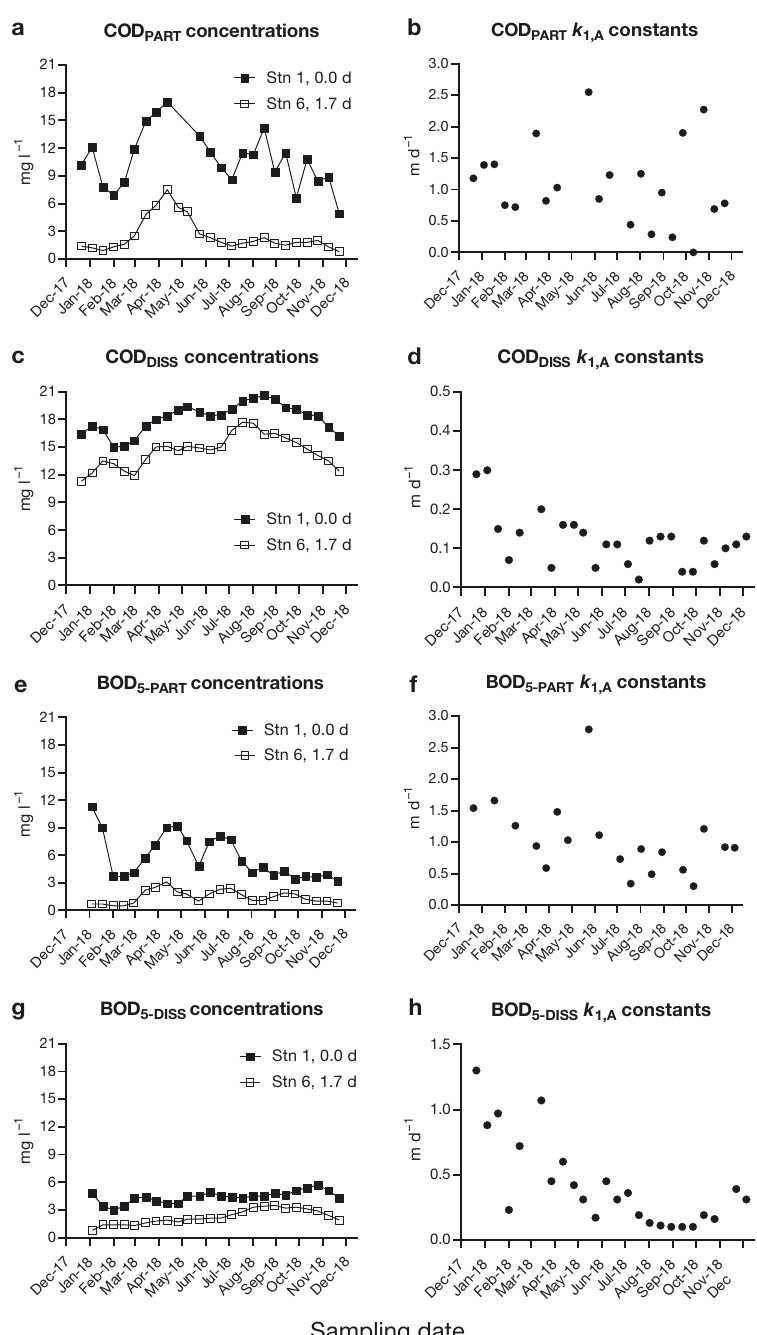
Fig. 5. Seasonal and longitudinal changes (d = hydraulic retention time in days) in organic matter concentrations (mg l −1 ) shown as 3-point moving aver- ages (only Stns 1 and 6 shown for simplicity) and associated removal rate con- stants ( k 1,A , m d −1 ) of (a,b) particulate (COD PART ) and (c,d) dissolved chemical oxygen (COD DISS ), and for (e,f) particulate (BOD 5-PART ) and (g,h) dissolved biochemical oxygen demand measured over 5 d (BOD 5-DISS